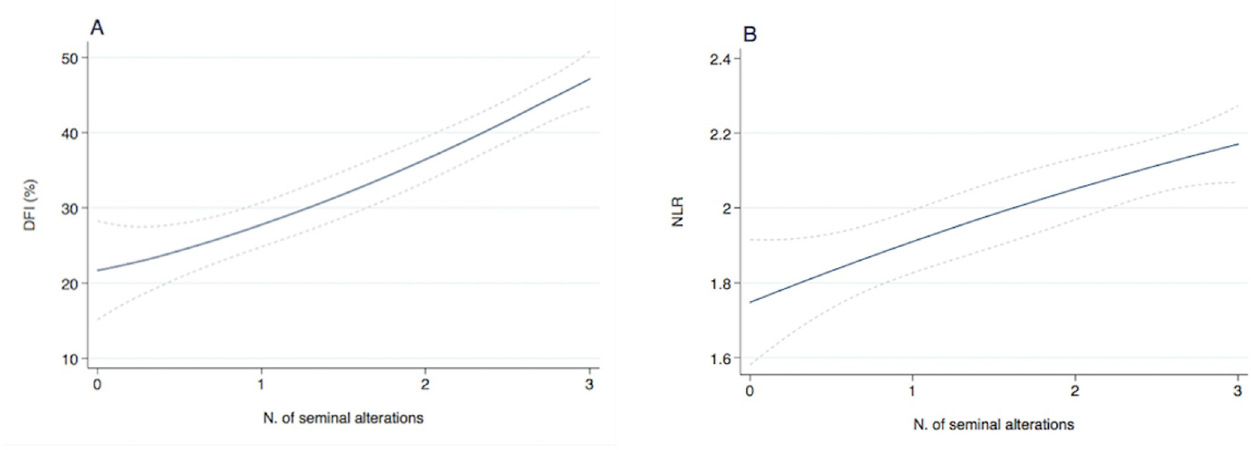
Fig 1. Estimated sperm DNA fragmentation (SDF) (A) and neutrophil-to-lymphocyte ratio (NLR) (B) according to the number of sperm alterations in infertile men. Dashed lines represent 95% CI.